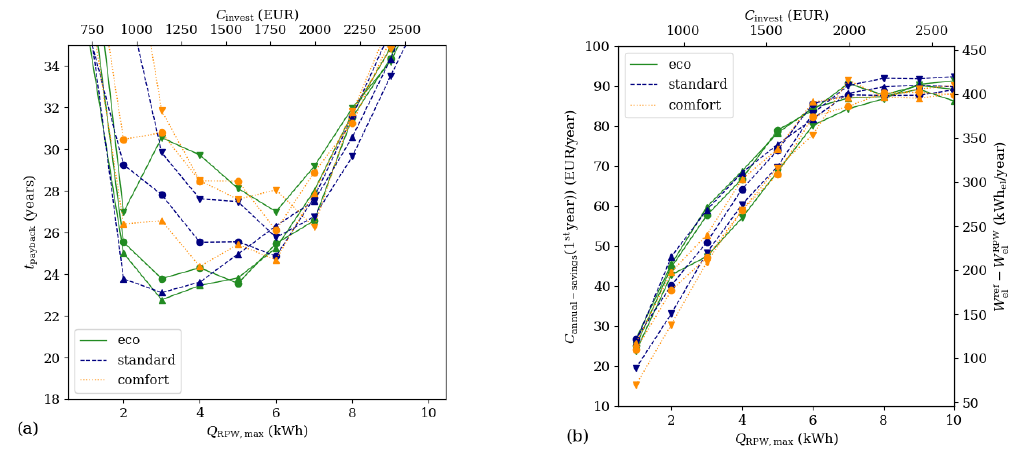
Figure 5. Payback time ( a ) and savings per year ( b ) for Case #3 (refurbished building located in Athens). Markers “ ▼ ”, “●” and “ ▲ ” denote small (140 L), medium (210 L) and large (280 L) decentralized DHW storage devices.